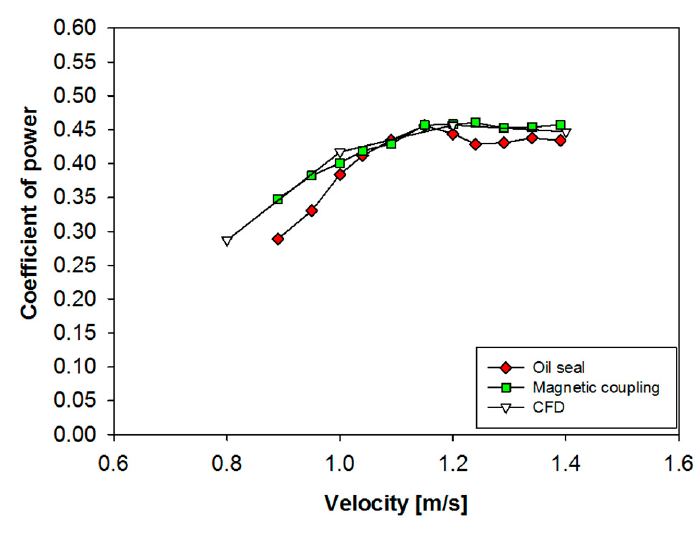
Figure 13. The Coe ffi cient of Power (Cp) for 3 cases are Figure 13. The Coefficient of Power (Cp) for 3 cases are compared.